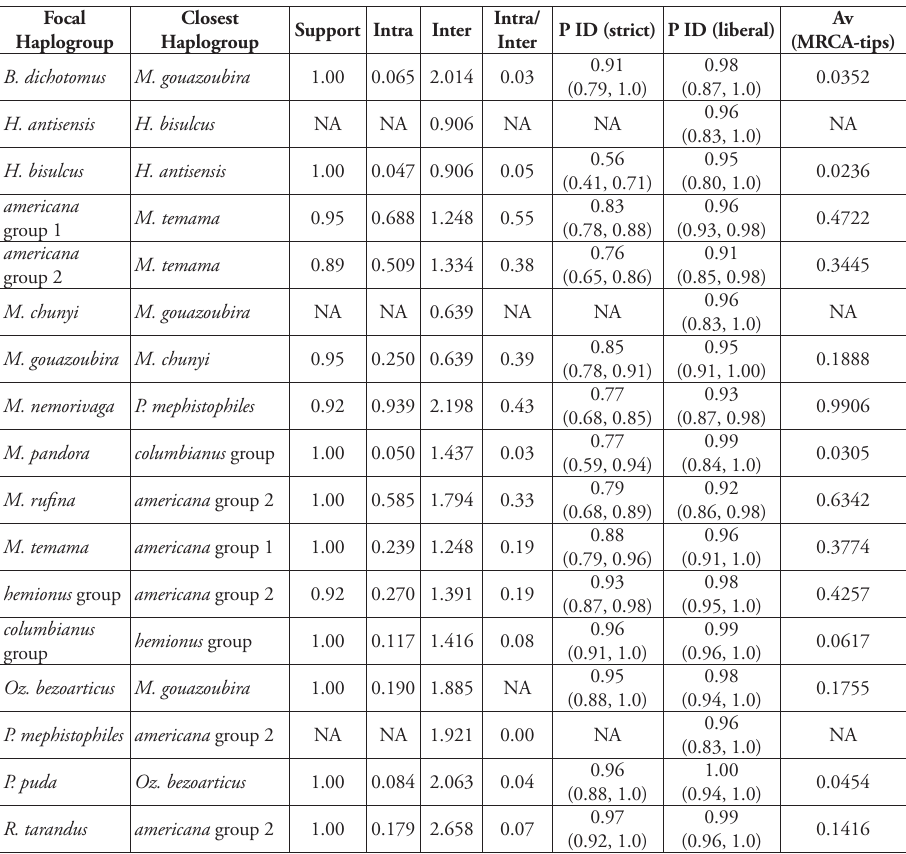
Table 3. Summary statistics from the Species Delimitation plugin of Geneious for haplogroups of Rangif- erini and Odocoileini deer recovered in the Bayesian tree. Focal haplogroup support: posterior probability values; Intra: The average pairwise tree distance among members of the focal haplogroup; Inter: the average pairwise tree distance between the focal haplogroup and the members of the closest haplogroup; Intra/ Inter: the ratio of Intra to Inter; P ID (strict): the mean (95% confidence interval) probability of correctly identifying an unknown member of the focal haplogroup using the criterion that it must fall within, but not sister to, the species clade in a tree; P ID (liberal): the mean (95% confidence interval) probability of correctly identifying an unknown member of the putative species using the criterion that it falls within, or sister to, the species clade in a tree; Av (MRCA-tips): the mean distance between the most recent common ancestor of a haplogroup and its